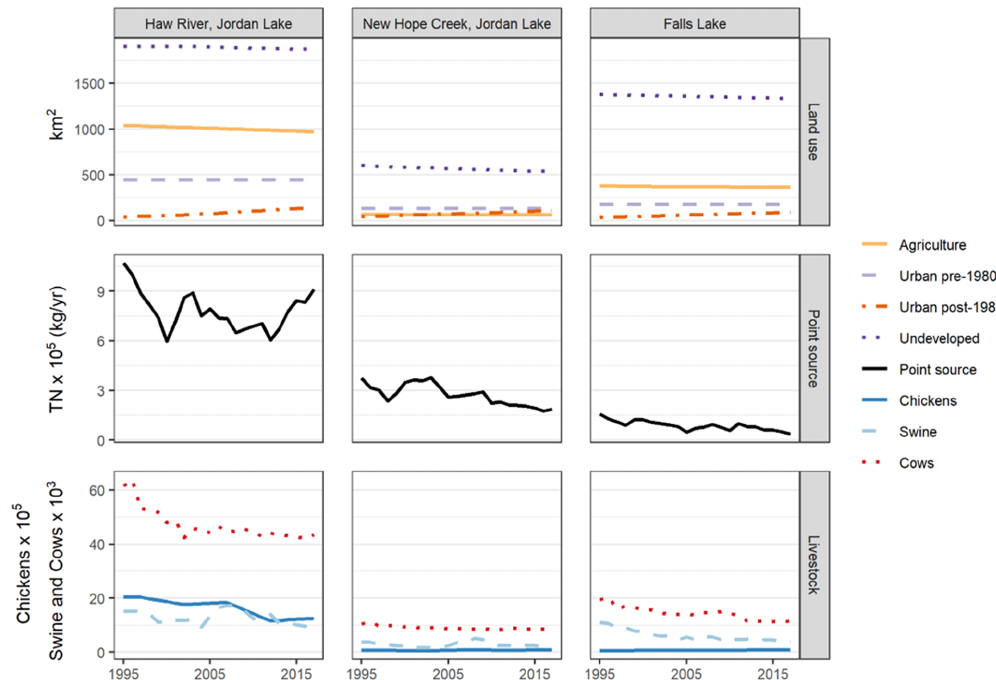
Figure 2. Land use, point sources, and livestock trends from 1994–2017 in the Haw River, New Hope, and Falls Lake basins.